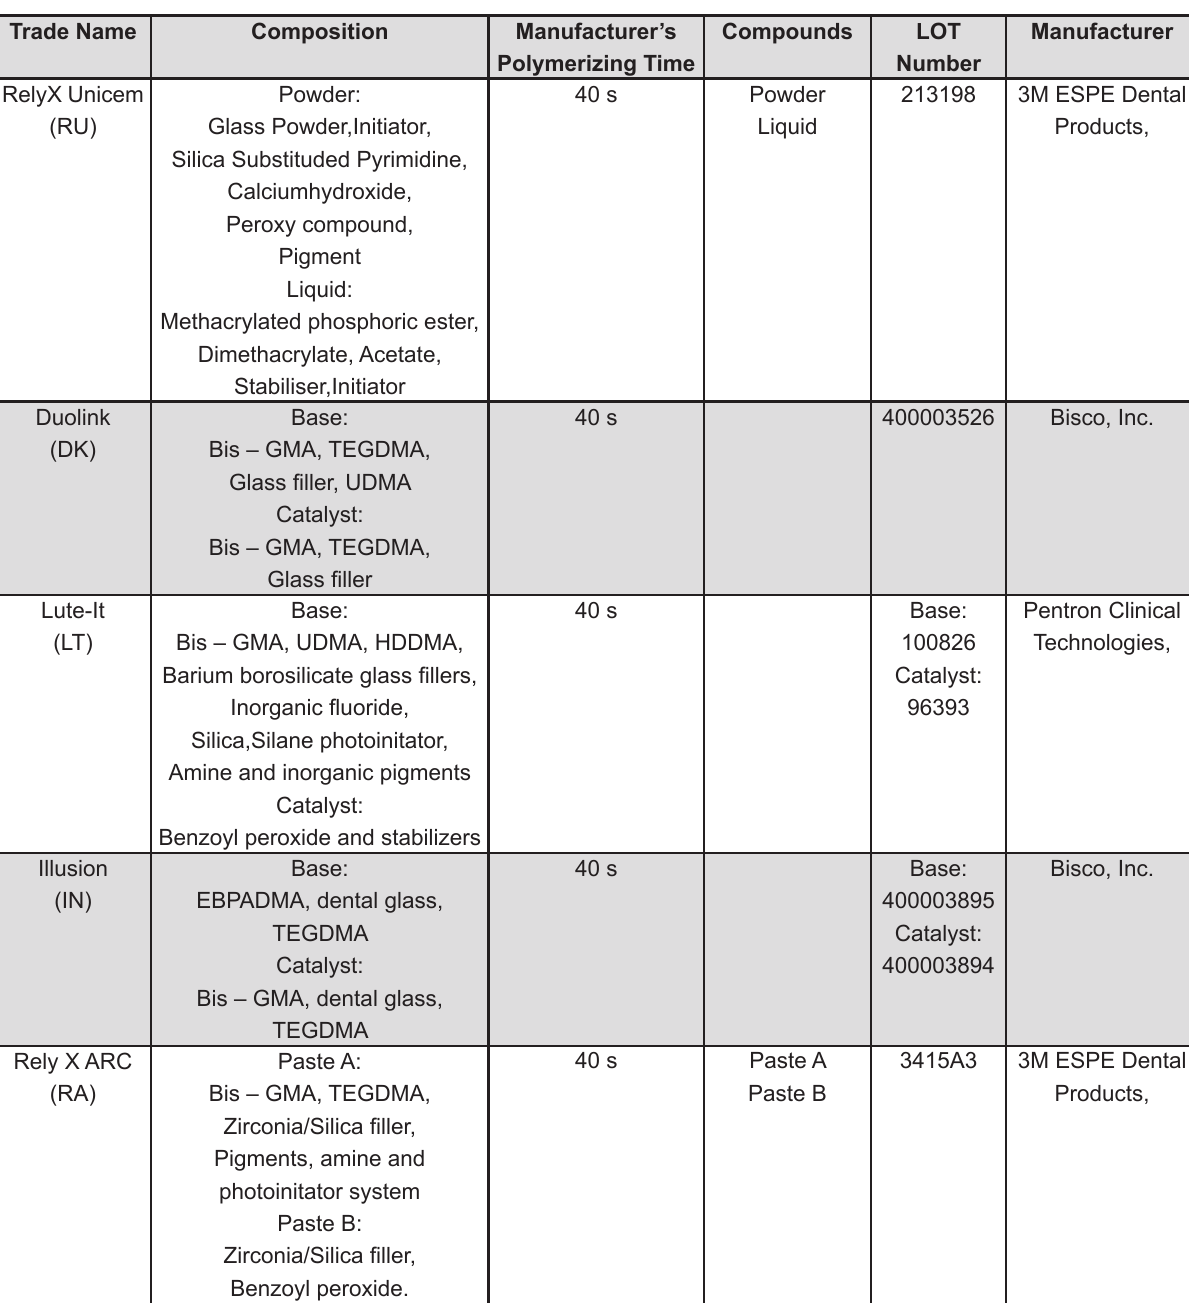
Figure 1- Tested materials and their composition according to